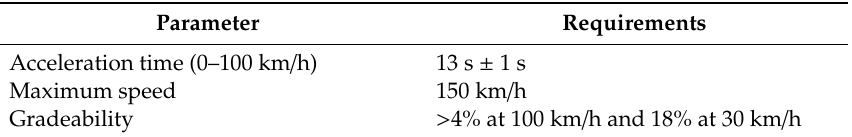
Table 2. Requirements of performance for the vehicle.